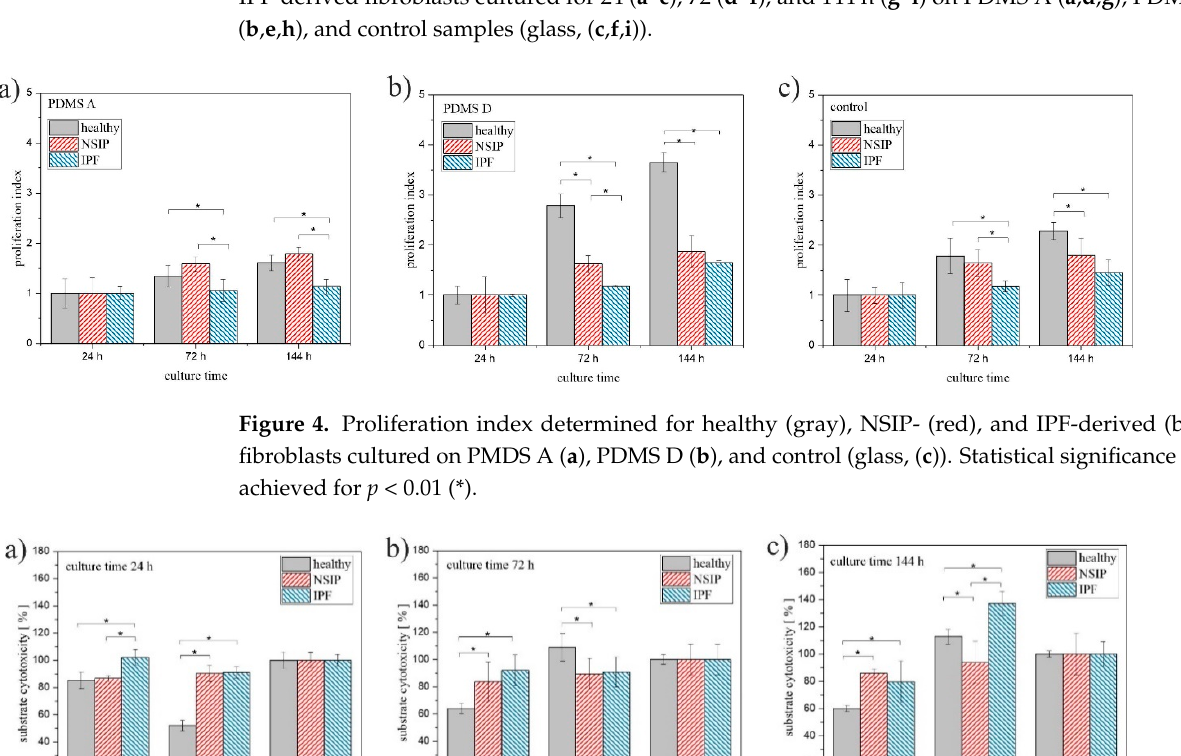
Figure 4. Proliferation index determined for healthy (gray), NSIP- (red), and IPF-derived (blue) fi- broblasts cultured on PMDS A ( a ), PDMS D ( b ), and control (glass, ( c )). Statistical significance was achieved for p < 0.01 (*).